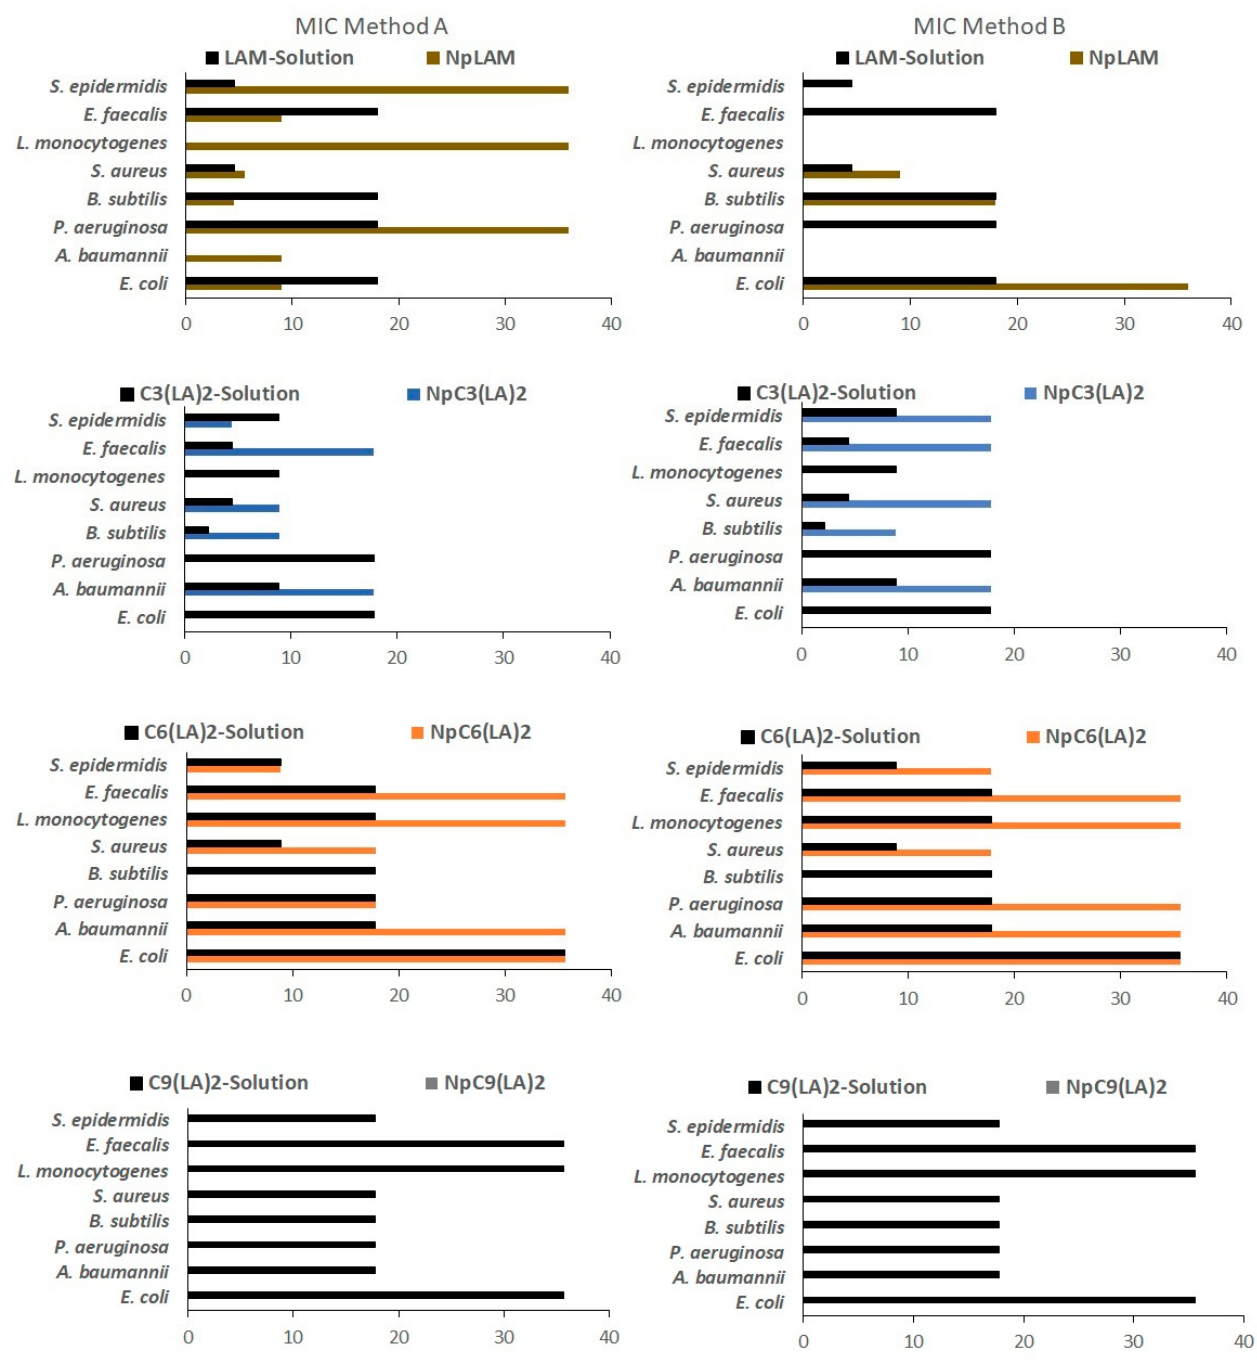
Figure 15. Determination of the MIC ( µ g/mL) for LAM, C 3 (LA) 2 , C 6 (LA) 2 , C 9 (LA) 2 solutions and loaded zein nanoparticles prepared by methods A and B against bacteria.